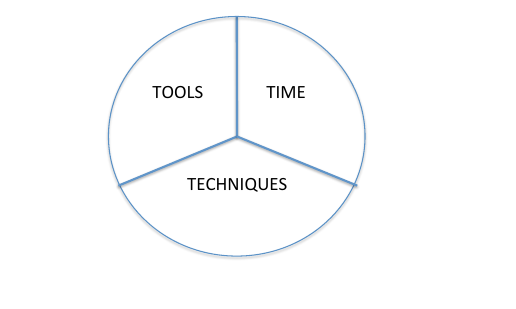
Fig. 3: Social Labs 3T’s